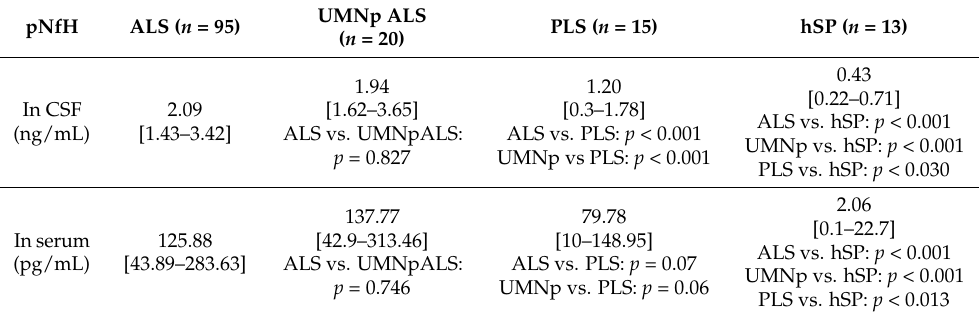
Table 3. pNfH in CSF and serum in different clinical groups characterized by UMN